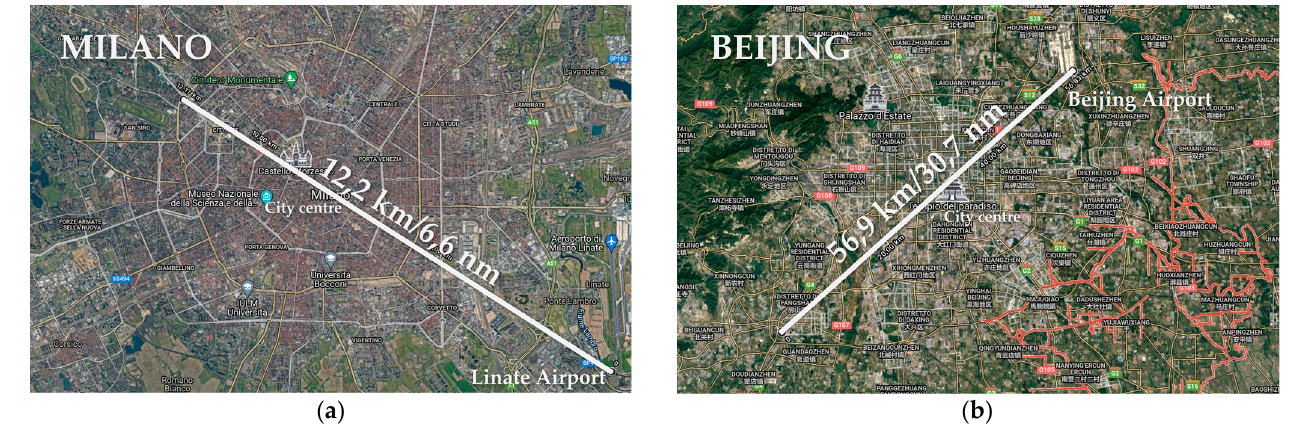
Figure 16. Pictures of potential UAM scenario: ( a ) Milan; ( b ) Beijing.